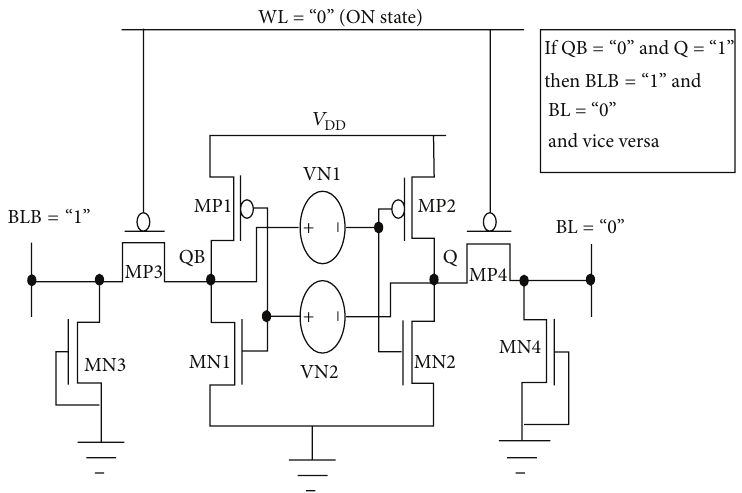
Figure 14: Test circuit for measurement of WSNM of MPT8T.